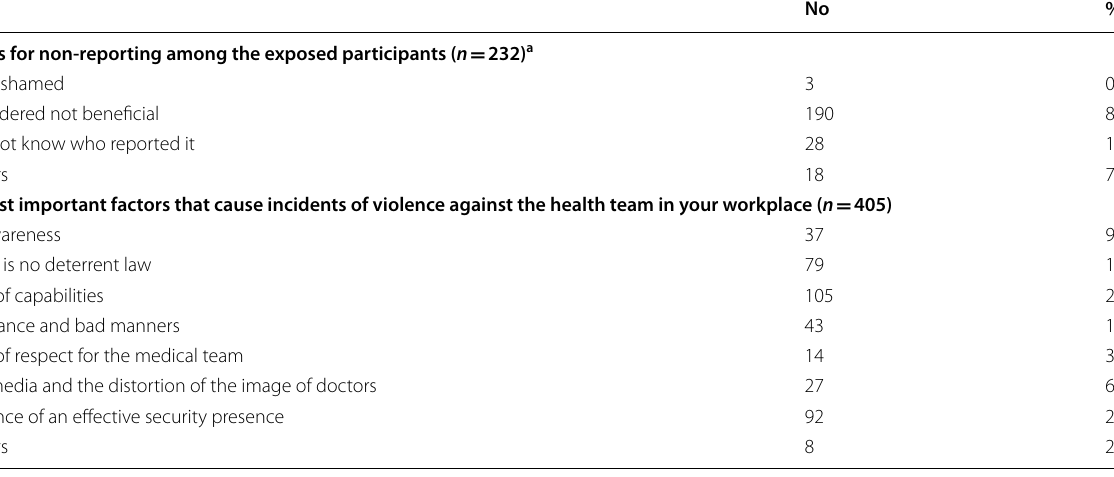
Table 5 Reasons for non‑reporting exposure to violent events and the most important factors that cause incidents of violence